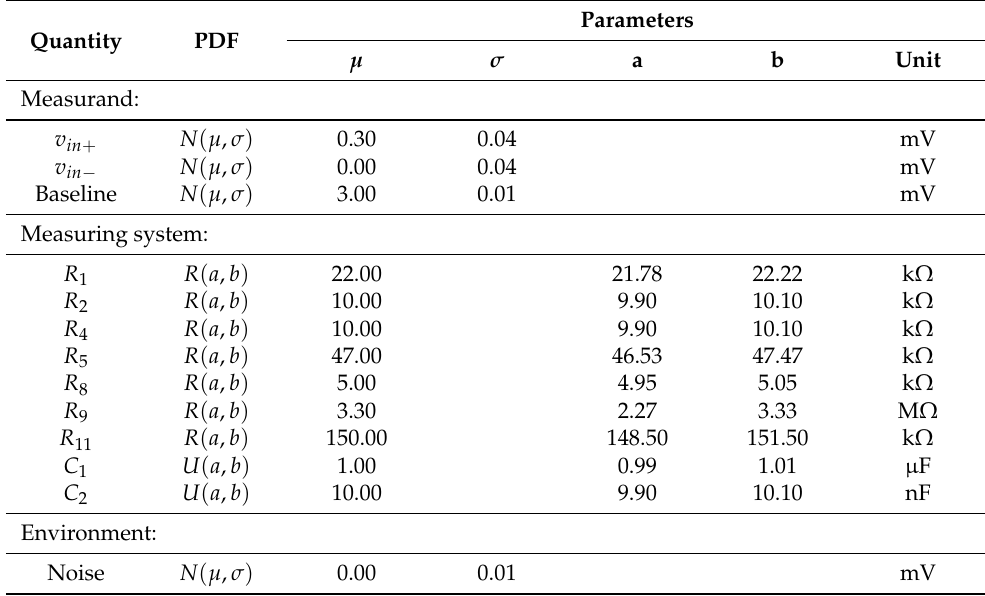
Table 2. The input quantities and their PDFs assigned on the basis of available information. Quantity PDF